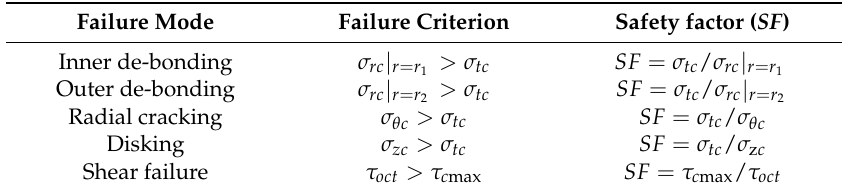
Table 1. Safety factor for cement sheath.